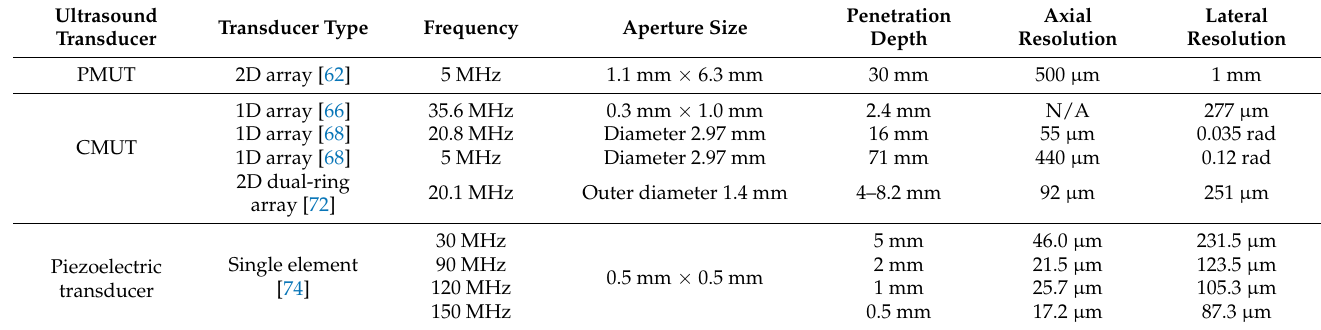
Table 4. A summary of IVUS imaging qualities using PMUT and CMUT compared with piezoelectric ultrasound transducers. Ultrasound